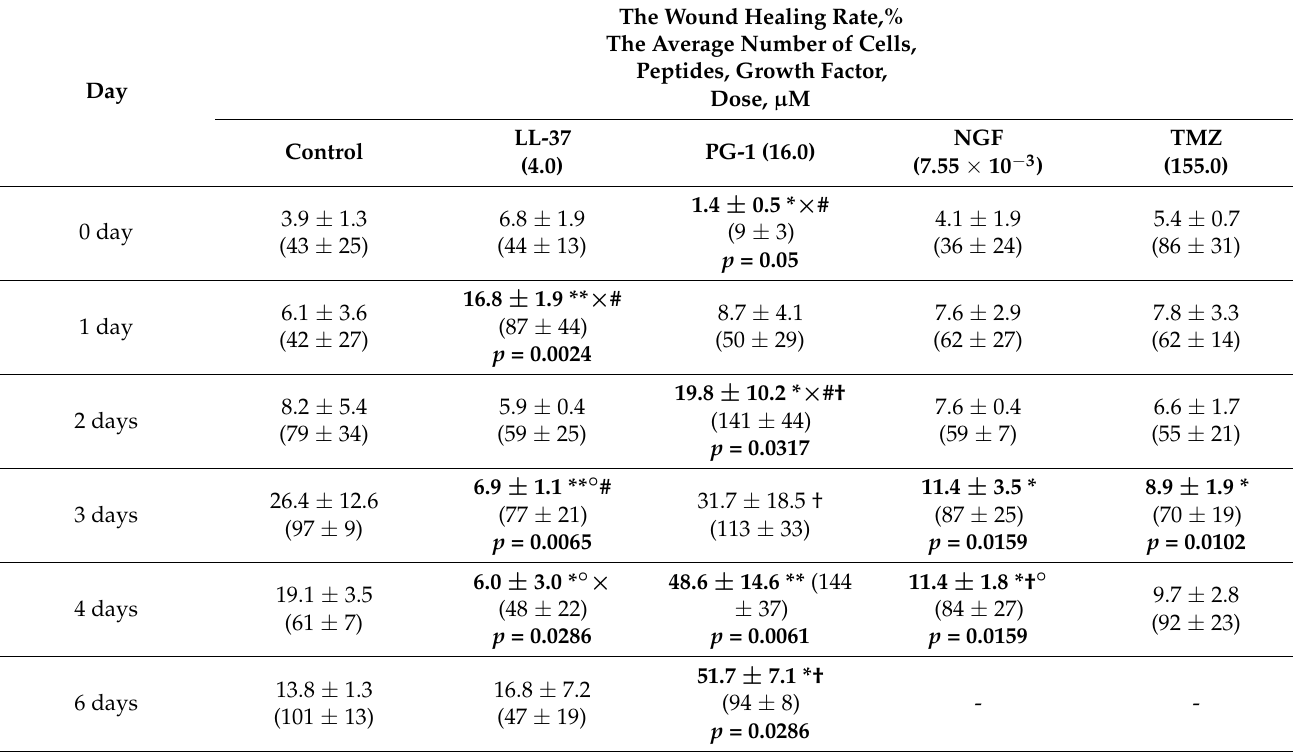
Table 2. Quantitation of human glioma U251 cells migration. The wound healing rate, %. The Wound Healing Rate,% The Average Number of